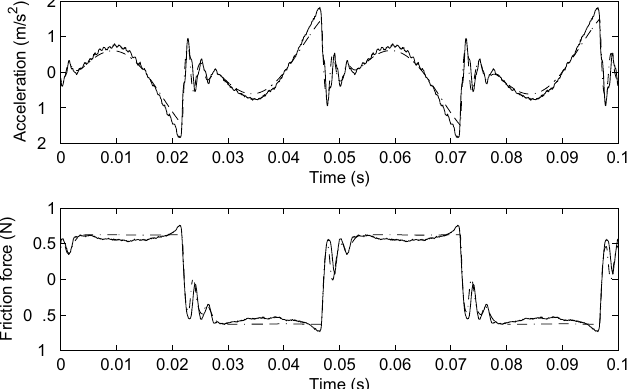
Fig. 14. Time history of the acceleration and the friction force for the set-up with the MB Dynamics Modal 50A shaker with F ex = 0 . 75 N, ω = 20 Hz and γ N = 0 . 511 N. Experimental time history ( −− ) and simulated time history ( ·−· ). Side-by-side comparisons between experimental and simulation results, obtained with the LuGre friction model, are presented. It is concluded that for small displacement LRD contacts friction modelling, the use of the LuGre friction model allows an adequate representation of the dynamics of the